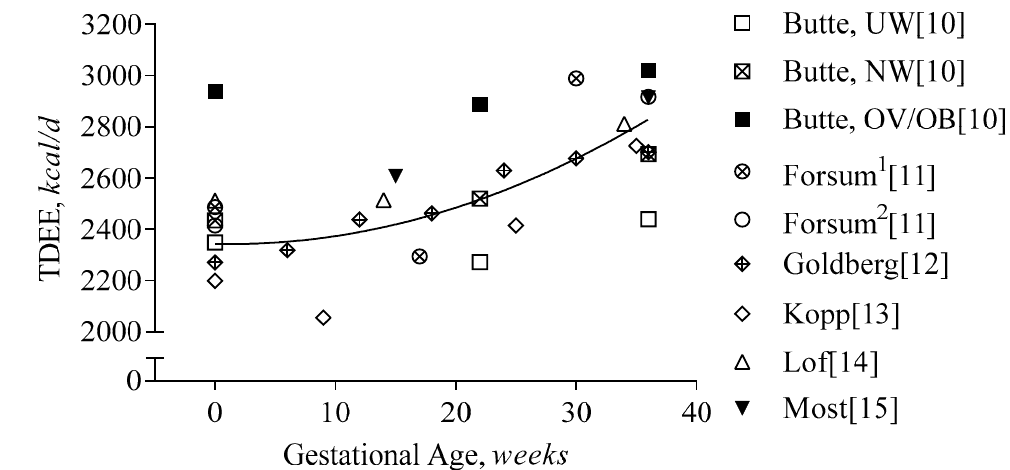
Figure 2. Total Daily Energy Expenditure during Gestation. Total daily energy expenditure (TDEE) is presented per study and gestational age (GA). The regression line represents the average increase during gestation (TDEE[ kcal / d ] = 2343 − 1 × GA[ weeks ] + 0.4 × GA 2 [ weeks ], R 2 = 0.62). Forsum 1 and Forsum 2 indicate the two di ff erent cohorts in the study: both measured before pregnancy, but at di ff erent times during gestation; Butte reported the changes in TDEE per BMI class: ‘UW’ indicates underweight: BMI ≤ 19.8 kg / m 2 , ‘NW’ indicates normal weight: BMI 19.8–26 kg / m 2 , and ‘OV / OB’ indicates overweight / obesity: BMI ≥ 26 kg / m 2 .